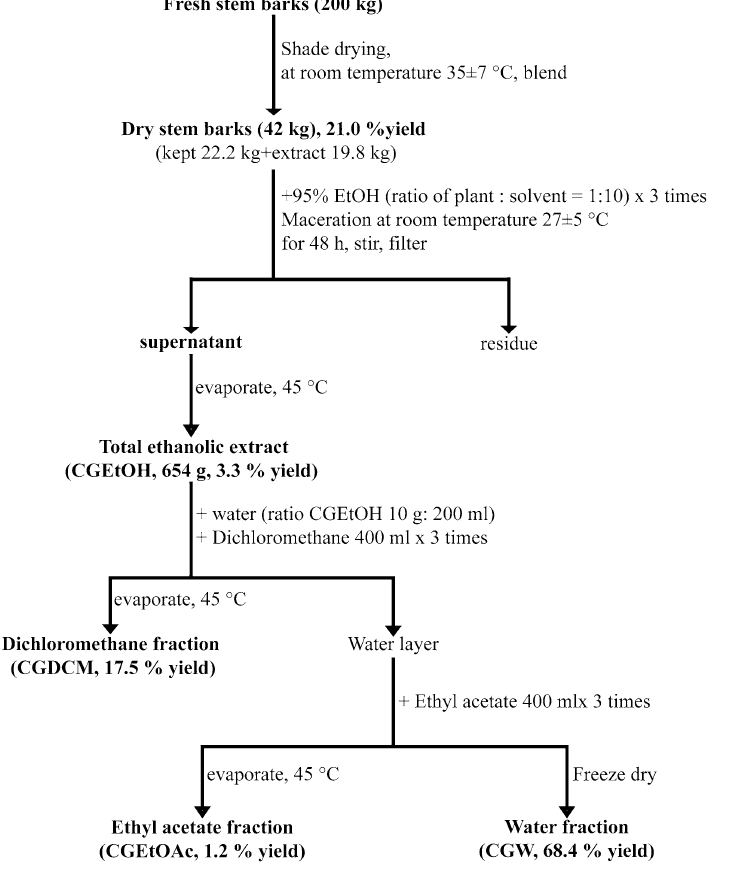
Figure 1. Extraction and fractionation protocols of C. gigantea stem bark to obtain the total ethanolic extract (CGEtOH), dichloromethane fraction (CGDCM), ethyl acetate fraction (CGEtOAc) and water fraction